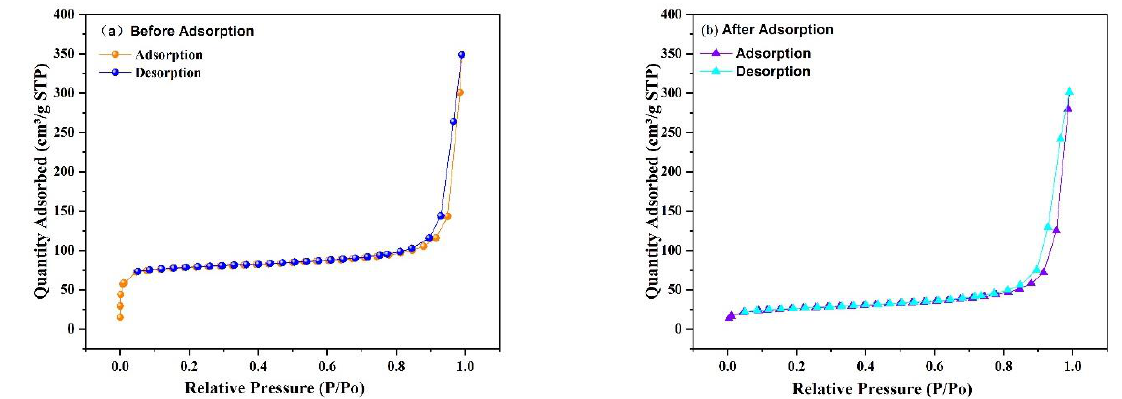
Figure 12. N 2 adsorption-desorption isotherms of Fe 3 O 4 @ZIF-8.